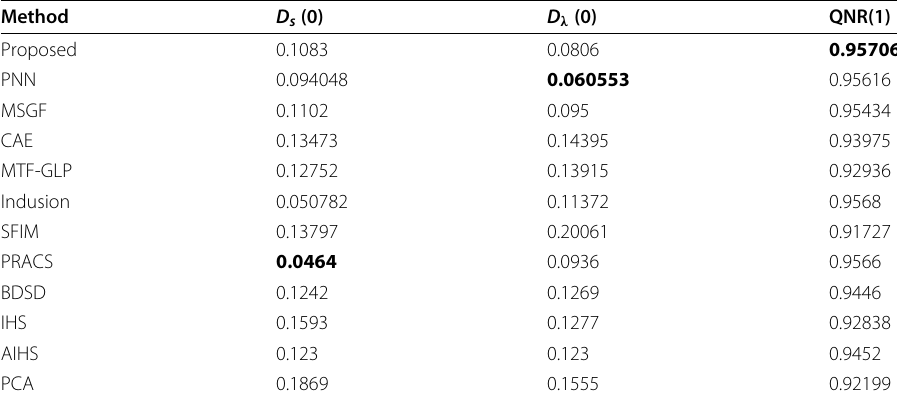
Table 7 Numerical results of the real GeoEye-1